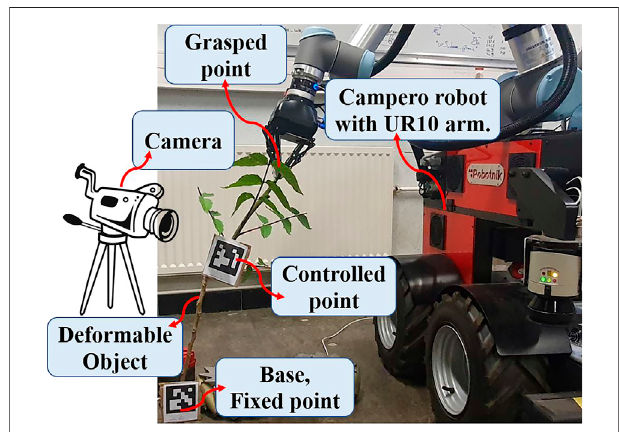
FIGURE 9 | The experimental setup used in this work.